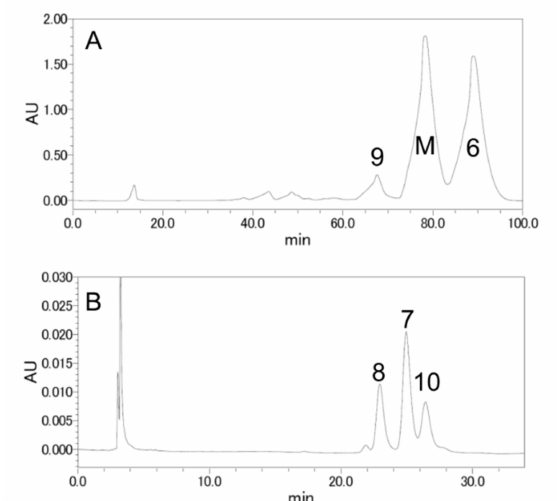
Figure 3. HPLC profile of target compounds 6 – 9 and compound 10 . After final reaction with 0.1% BHA in cyclohexane under reflux conditions for 1 h, the reaction mixture was concentrated. The compound which has the same Rf value (Rf = 0.4, AcOEt / n -Hex = 3:7) of TLC was purified using silica-gel column chromatography (AcOEt / n -Hex = 1:4). This compound was further purified with reverse-phase HPLC column chromatography, and the profile was shown in ( A) (column: Mightysil RP-18 GP 250-20 (5 µ m) Kanto Chemical Co., Inc, solvent: 100% acetonitrile; initially the flow rate was at 1 mL / min and it was increased to 5 mL / min over 1 min, and this condition was maintained, detector: 254 nm